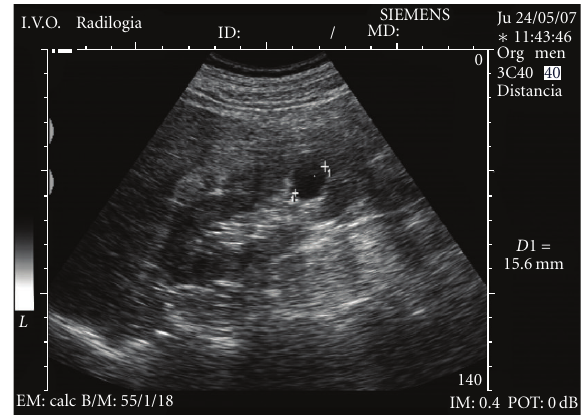
Figure 1: Simple cyst as anechoic lesion with a sharply defined back wall and enhancement of through sound